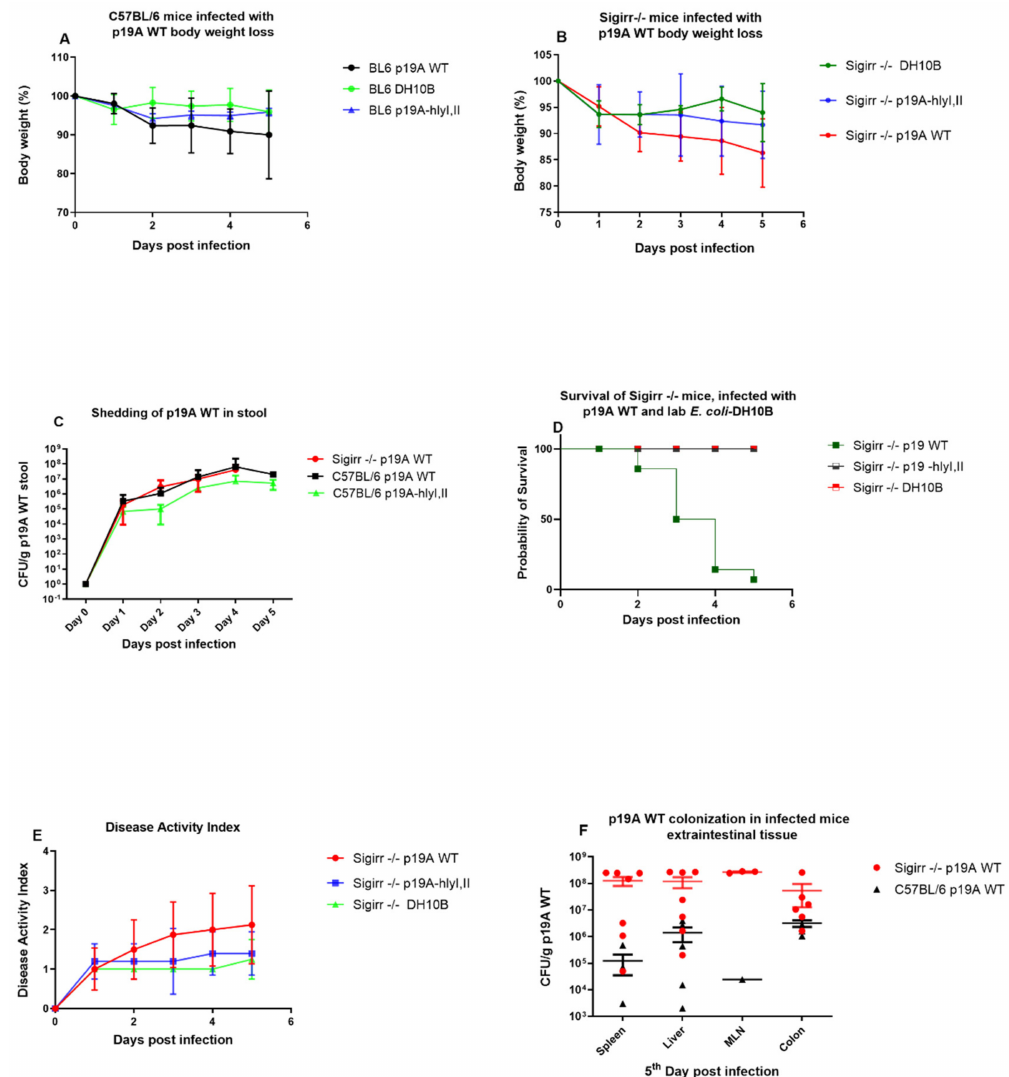
Figure 2. p19A WT infected mice: colonization and the course of infection. ( A ) p19A WT infected C57BL / 6 mice show ≤ 10% body weight loss, while the p19A ∆ hlyI, II and DH10B infected group had ≤ 5% body weight loss at day 5 post-infection, p < 0.05. ( B ) p19A WT infected Sigirr − / − mice showed ≤ 13.7% (mean value) body weight loss, while DH10B and p19A ∆ hlyI, II infected mice had ≤ 6% and ≤ 8% (mean value) body weight loss, respectively at day 5 post-infection, p < 0.0037. ( C ) There were no di ff erences in shedding of p19A WT and p19A ∆ hlyI, II in the stool of infected C57BL / 6 and Sigirr − / − mice at the 5th day post-infection (Kruskal–Wallis non-parametric test). ( D ) Survival analysis of p19A WT infected Sigirr − / − mice showed that 29% of the infected mice survived at 4th day post-infection, while 100% of the Sigirr − / − mice infected with p19A ∆ hlyI, II and DH10B survived until the 5th day post infection. ( E ) Disease activity index (DAI) for Sigirr − / − mice infected with p19A WT (DAI, mean ≈ 2.3), p19A ∆ hlyI, II and DH10B (DAI, mean ≈ 1.2), and C57BL / 6 mice infected with p19A WT (DAI, mean ≈ 2.5), at the 5th day post-infection. ( F ) Liver, spleen, metastatic lymph nodes (MLN) and colon of p19A WT infected C57BL / 6 1.4 × 10 6 to 1.1 × 10 5 ) and Sigirr − / − mice, 1.1 × 10 8 , were colonized with p19A WT at day 5 post-infection. The CFU in the liver and spleen, mean value 1.1 × 10 5 to 6.3 × 10 5 and 4.3 × 10 3 to 4.3 × 10 5 ,